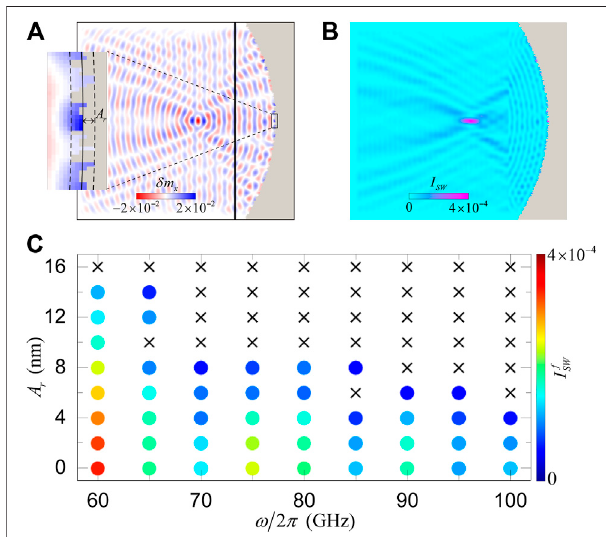
FIGURE 5 | (A) Snapshot of spin waves re fl ected from the parabolic edge with a random roughness, which is depicted by the formula x (cid:2) − y 2 /(4 x f ) + A r I r , where A r istheroughnessamplitudeand I r isarandomvalueintheinterval( − 1,1). The black bar shows the exciting source of spin waves with μ 0 h 0 (cid:2) 10 mT and ω /2 π (cid:2) 60 GHz. Theenlarged imageoftherectangular areaisshownonthe left. The solid line in the inset denotes the ideal parabolic edge, and the dashed linesshowtheamplitudeoftheroughness( A r (cid:2) 6 nm). (B) Thespinwaveintensity in (A) . (C) Phasediagramofthespinwaveintensityatthefocalpointasafunction of the roughness amplitude and the spin wave frequency. The black crosses representnospinwavefocusing,andthecoloreddotsarethespinwaveintensity.